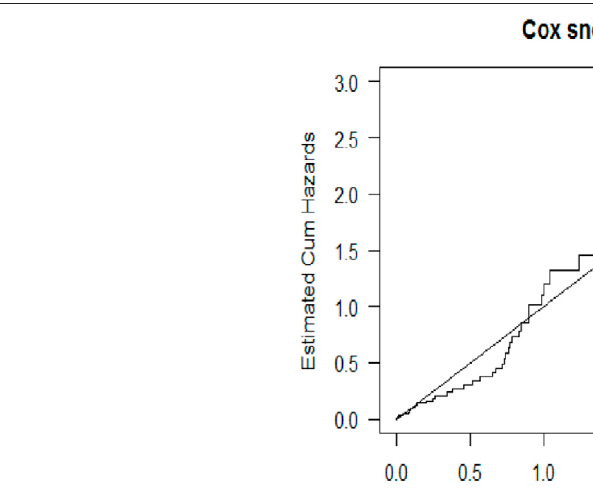
Figure S3 | Cox Snell residuals for assessing fi tness of Cox proportional hazard model.